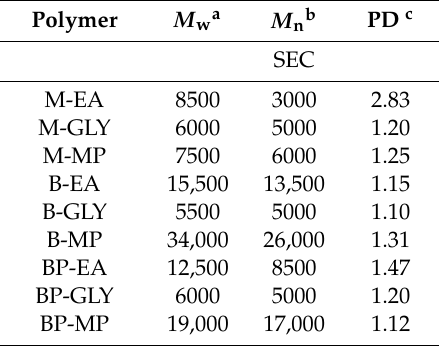
Table 4. Molecular weights of